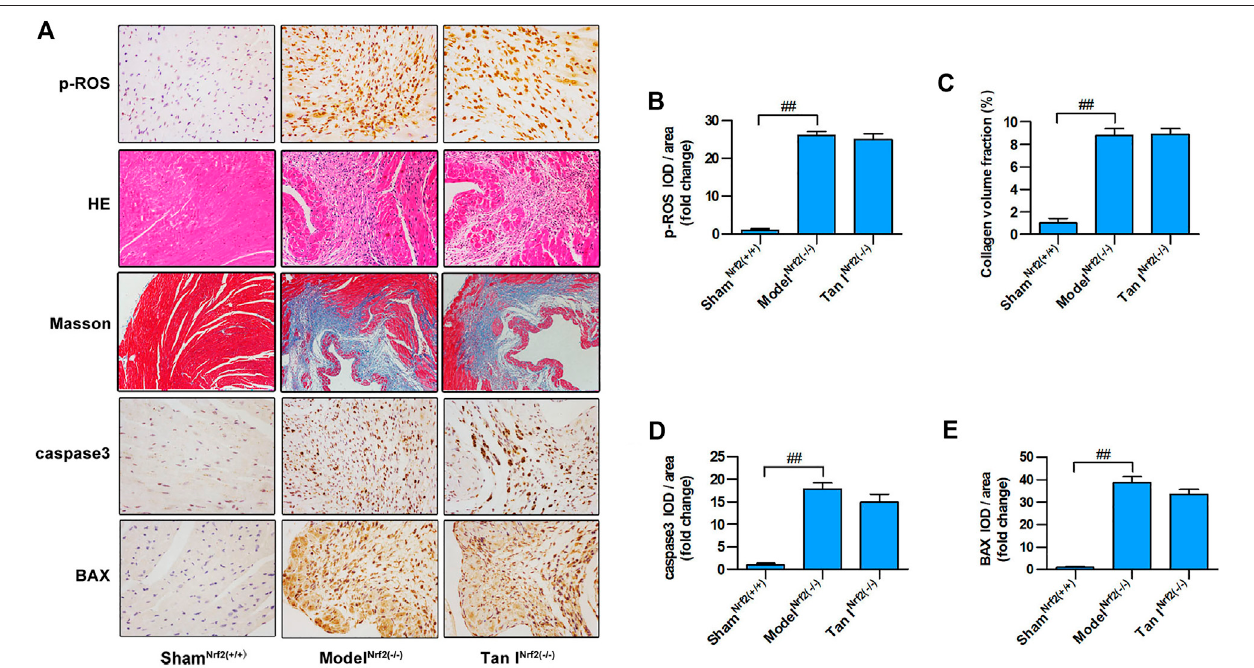
FIGURE 7 | Protective effects of Tan I on oxidative stress and oxidative stress – induced cardiomyocyte injury are partially blocked in Nrf2 ( − / − ) mice. (A) Hematoxylin – eosin (HE) staining; immunohistochemistry (IHC) analysis including p-ROS, caspase3, and BAX; and Masson ’ s trichrome staining. (B) Relative expression of p-ROS. (C) Collagen volume fraction. (D) Relative expression ofcaspase3. (E) Relative expression of BAX. Data are presented as mean ± S.D. ## p < 0.01, compared to the sham Nrf2(+/+) group ( n (cid:2)